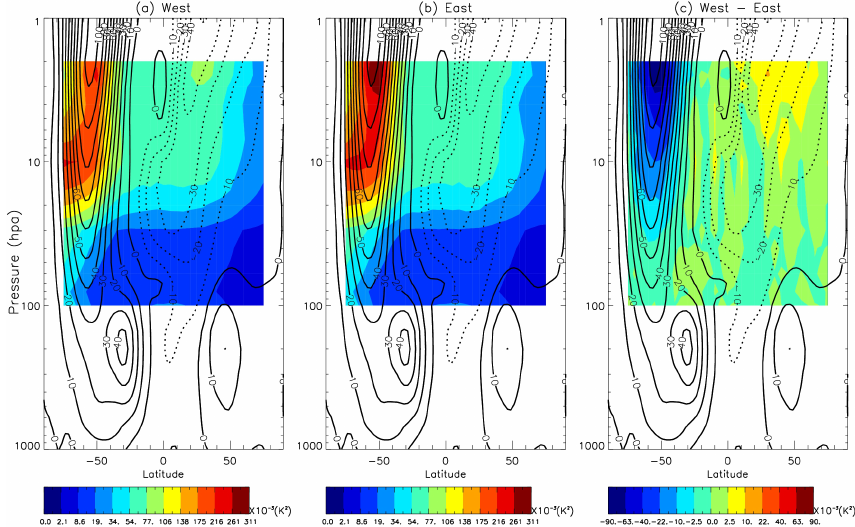
Figure B 2. Same with Fig. B1, except for 2005.07. Fig. B2. Same with Fig. B1, except for 2005.07.